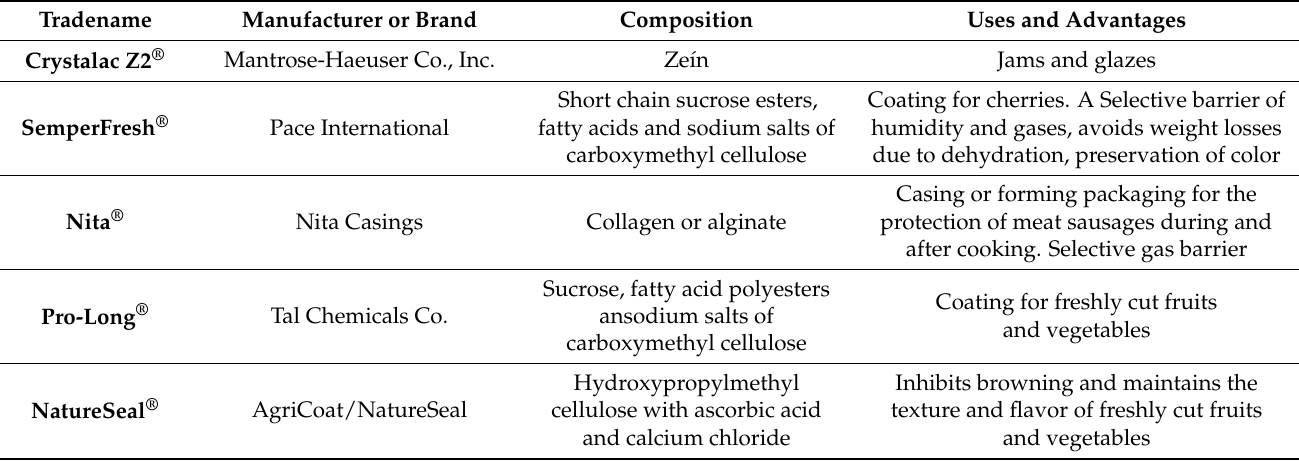
Table 2. Some edible films products available in the market